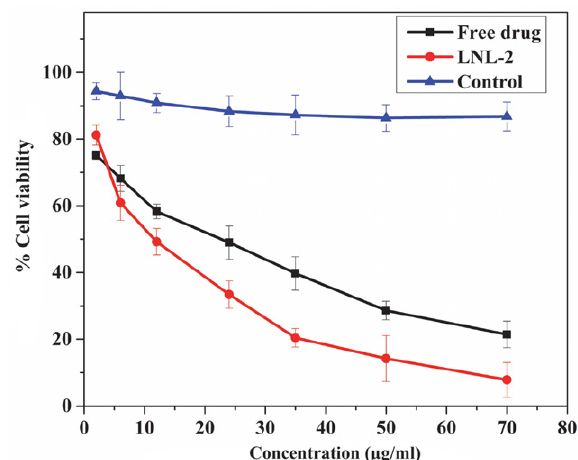
Fig. 3 . Comparison of percentage C6 cell viability upon treatment with optimized lomustine loaded lipid nanostructures (LNL-2), free drug, and blank lipid nanostructures